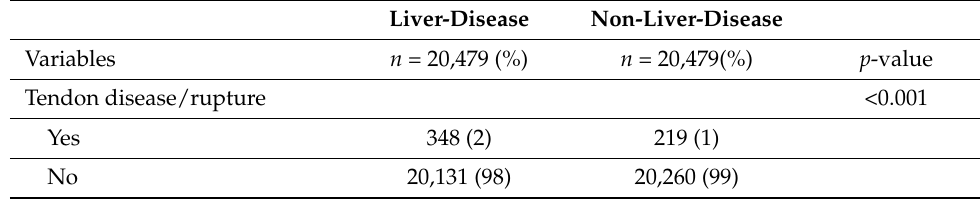
Table 2. Outcomes at the